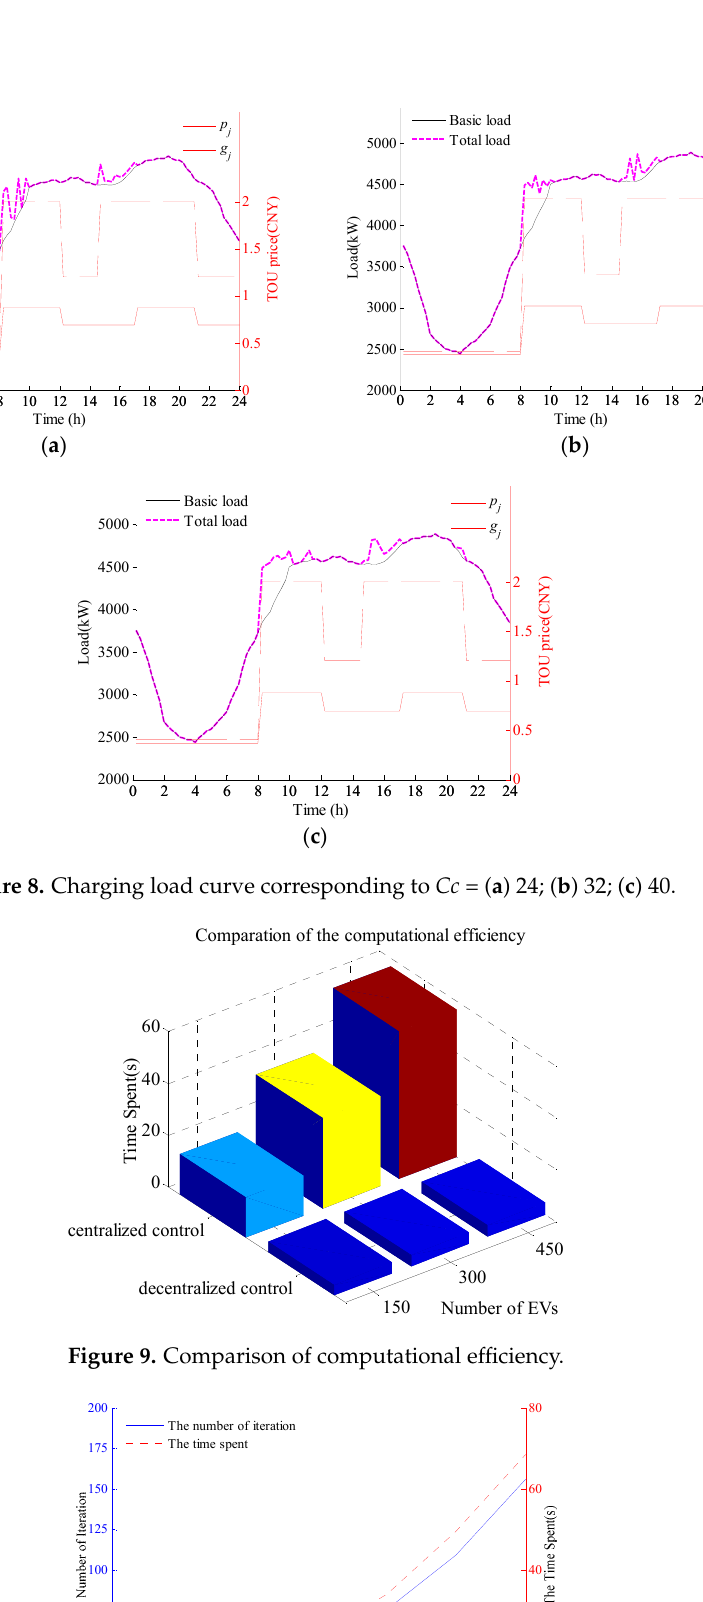
Figure 10. Relationship between the initial value λ 0 and the convergence rate.